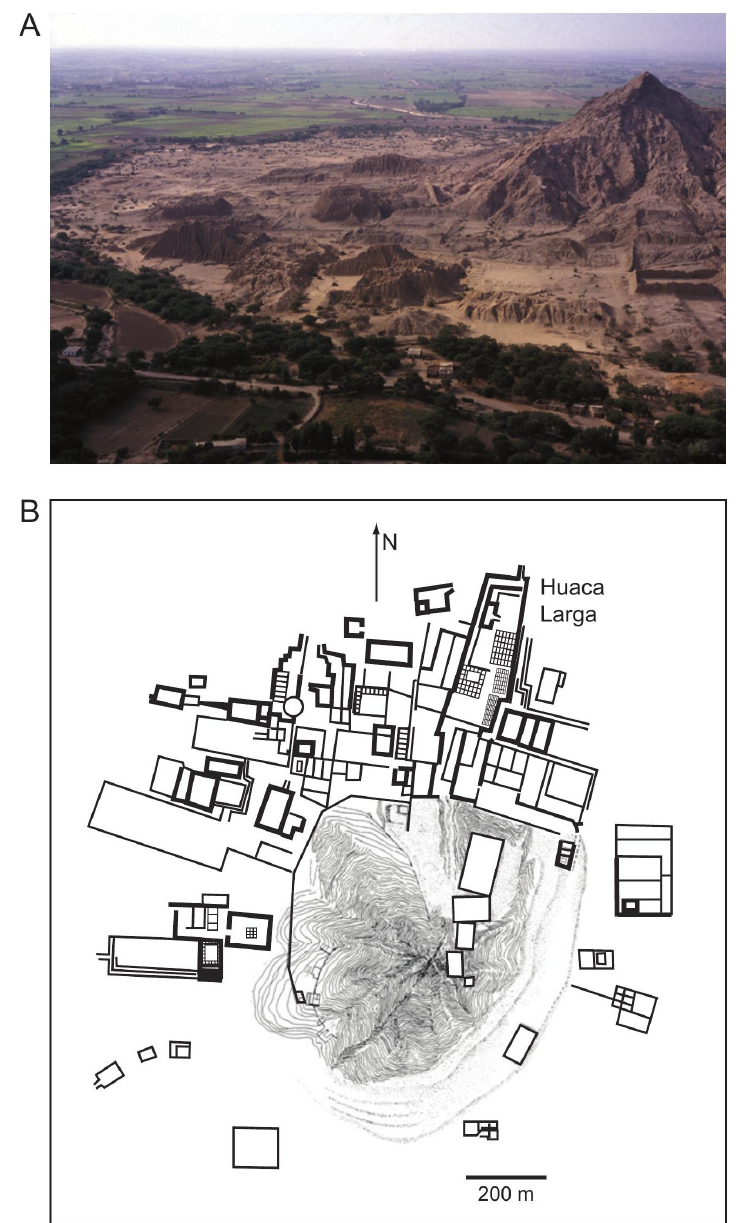
Figure 5. T ú cume site. ( A ) Photo of the monumental sector at T ú cume. (Photo by Daniel H. Sandweiss) ( B ) Schematic map of the T ú cume site. (Map adapted by Kirk A. Maasch from [3]: Figure 5. Túcume site. ( A ) Photo of the monumental sector at Túcume. (Photo by Daniel H. Sand- Figure 33, based on [26]: weiss) ( B ) Schematic map of the Túcume site. (Map adapted by Kirk A. Maasch from [3]: Figure 33,